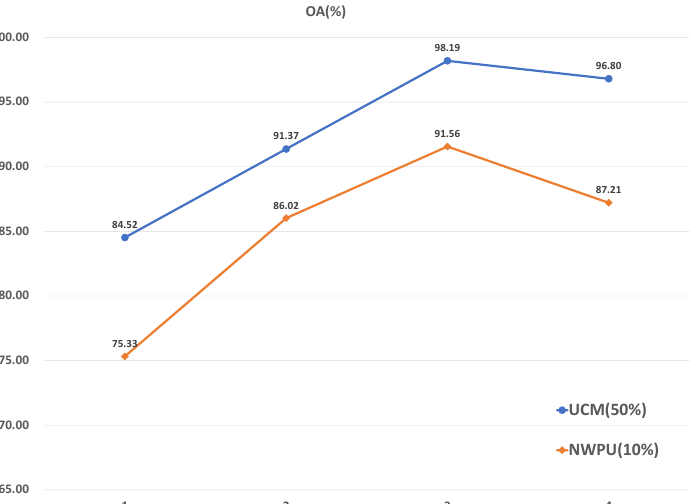
Figure 15. Effect of the number of RDAB modules on the classification accuracies in UCM and NWPU